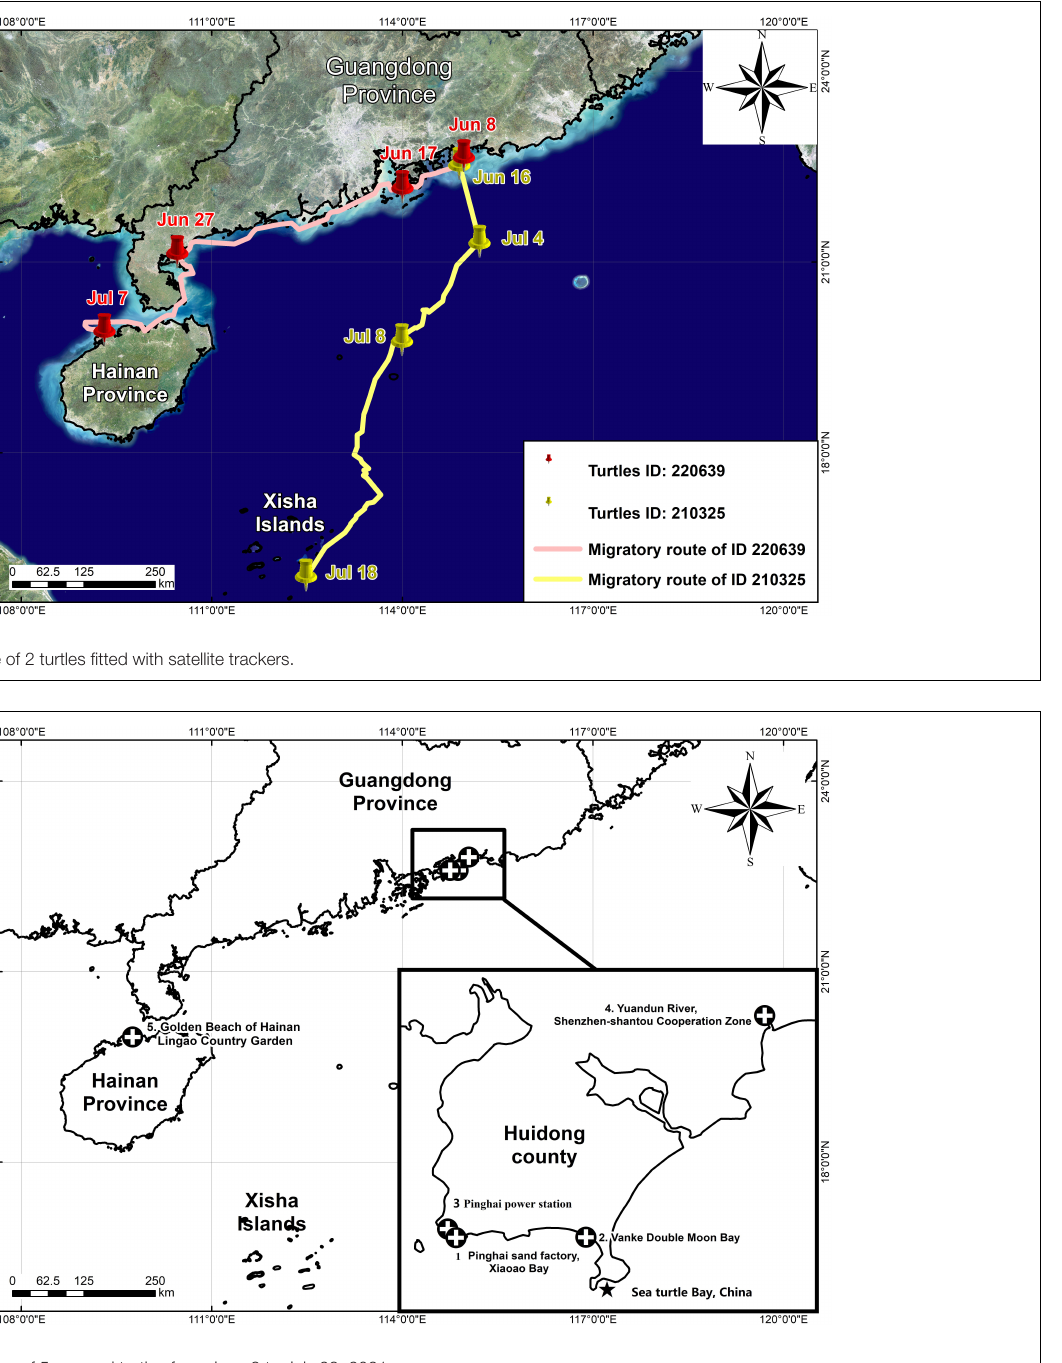
FIGURE 2 | Rescue locations of 5 rescued turtles from June 8 to July 28,